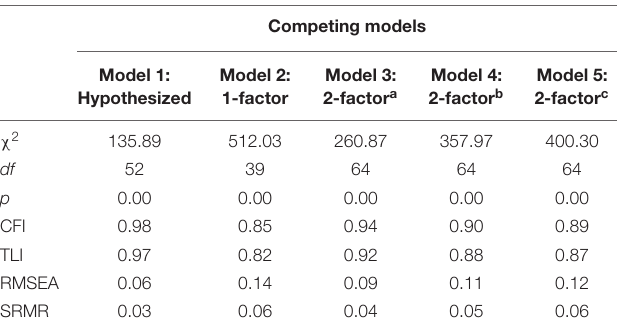
TABLE 6 | Measurement model fit comparisons (Sample